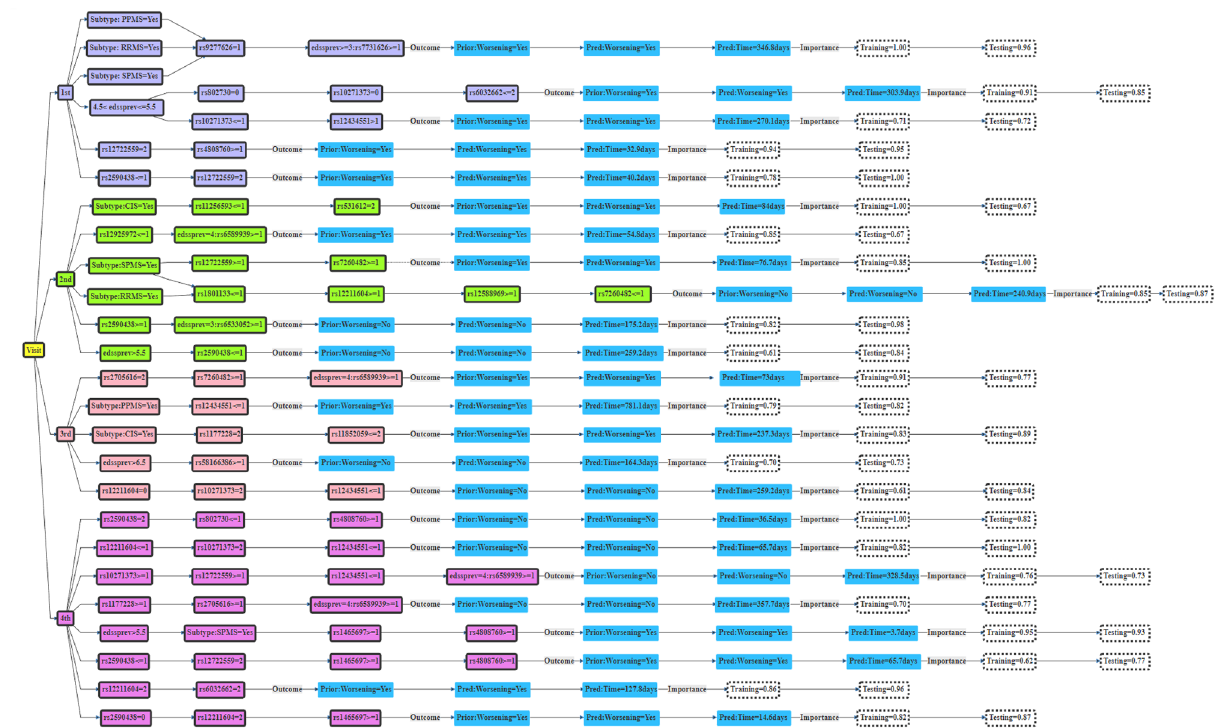
Figure 6. Genetic decision rules for predicting future worsening of disability for PwMS. These rules indicate how the MErf ensemble model combines allele dosages from a set of influential genetic variants amongst the 28 candidates SNPs to make prediction decisions regarding future disability. Each rule indicates the expected EDSS transition time conditional on the effects of genetic variants, MS disease course (MSTYPE), and previous disability histories (EDSSPREV). Only rules for the first four visits have been